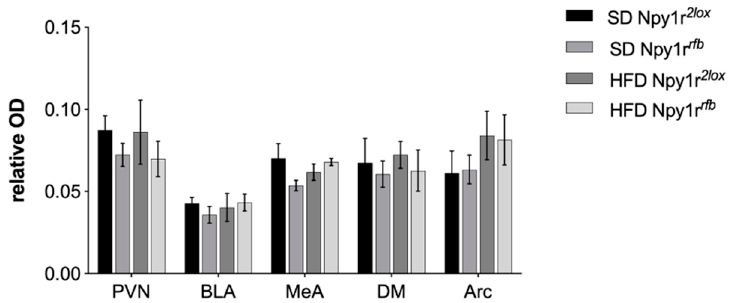
Figure 7. Relative optic densities (OD) of Npy1r mRNA expression in the hypothalamus and amyg- dala of Npy1r 2lox and Npy1r rfb mice fed with SD and HFD. PVN, paraventricular hypothalamic nucleus; DM, dorsomedial hypothalamic nucleus; ARC, arcuate hypothalamic nucleus; BLA, basolat- eral amygdala; MeA, medial amygdala.